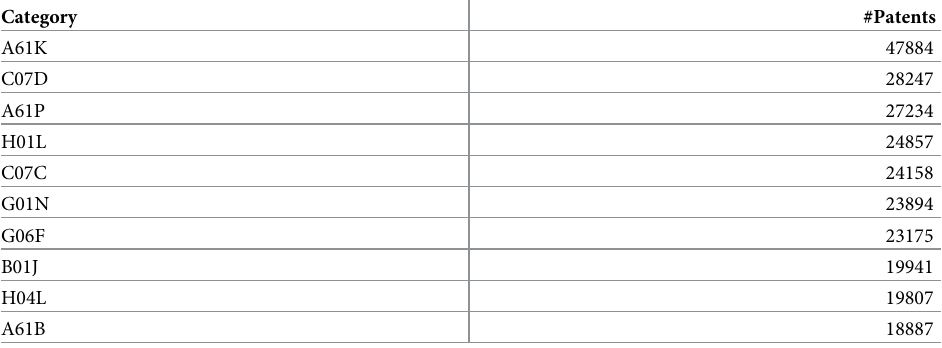
Table 2. Category wise distribution of patents (top